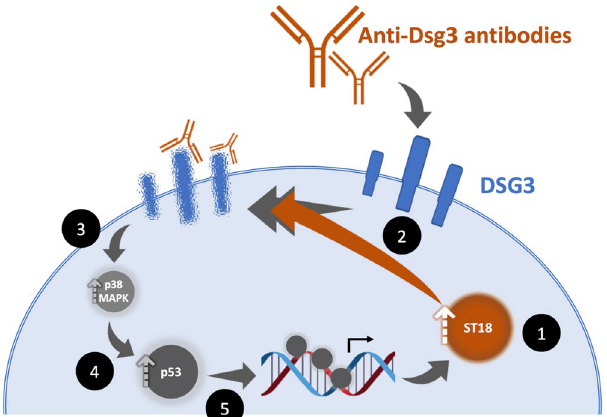
Figure 4. ST18 drives a p53-dependent self-amplifying process promoting autoantibody-mediated membranal DSG3 down-regulation in pemphigus vulgaris. Genetically determined ST18 overexpression (1) enhances autoantibodies-induced DSG3 down-regulation in keratinocytes (2, orange arrow) which triggers p38MAPK- dependent (3) p53 activity (4), which in turn up-regulates ST18 promoter activity (5), thus setting the stage for a self-amplifying pathogenetic cycle in